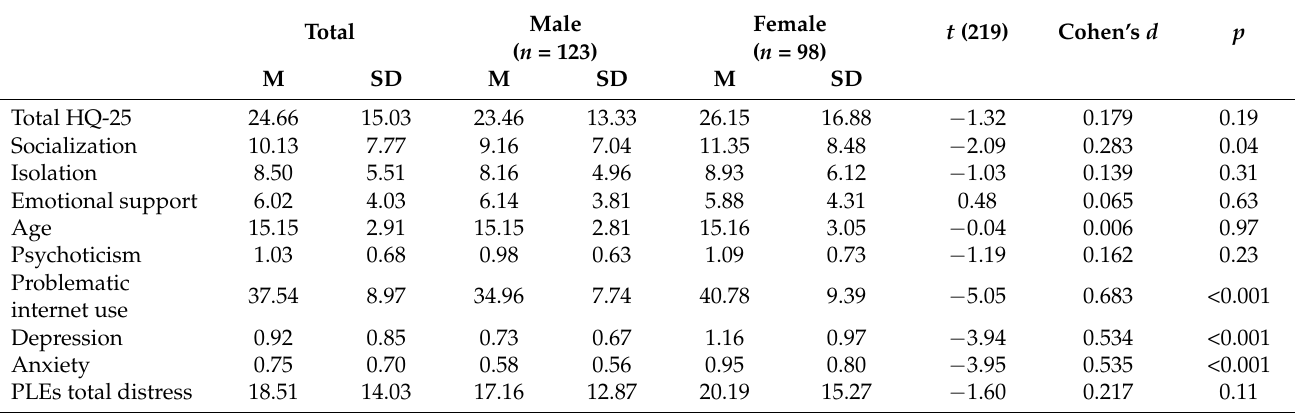
Table 3. Descriptive statistics according to